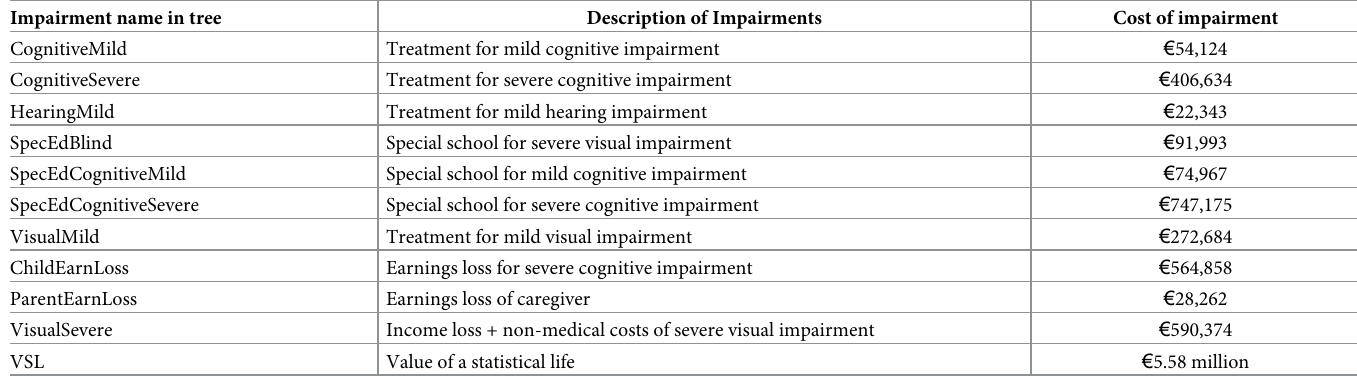
Table 4. Costs due to